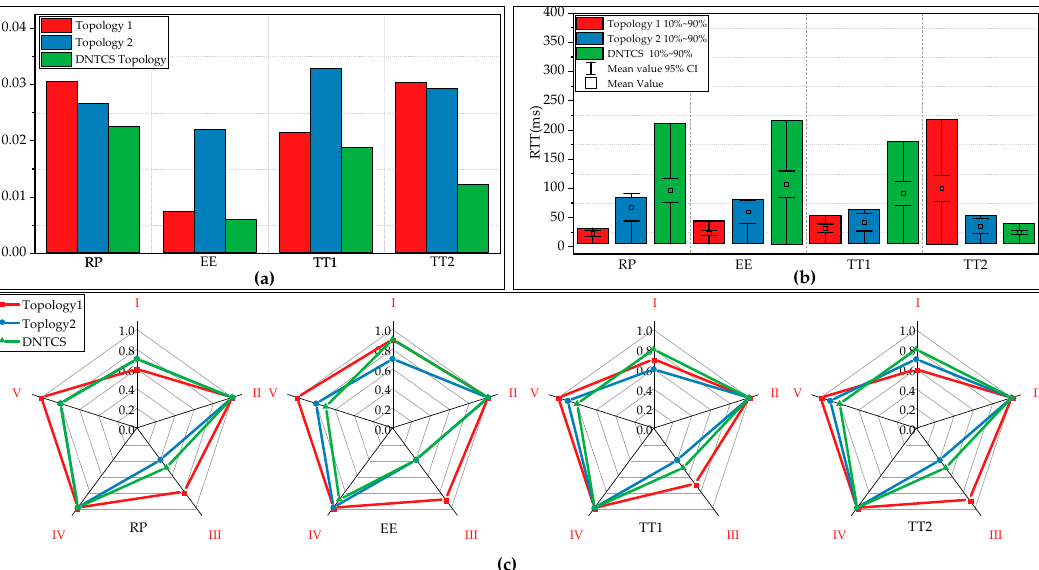
Figure 17. Results for Scenario 1 in the DBTRN regarding the network performances of the mobile nodes. ( a ) Packet loss rate; ( b ) RTT; ( c ) normalized performance metrics.